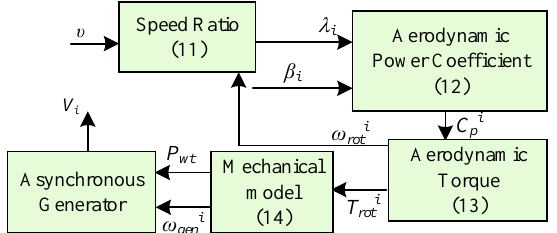
Figure 12. Conceptual model of the Fixed-speed wind generator